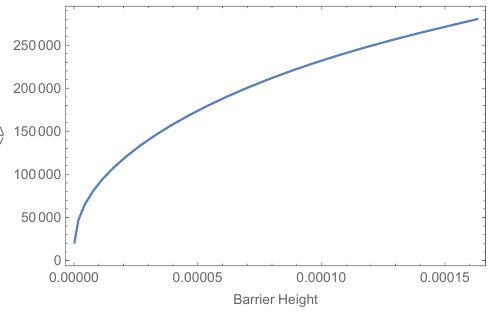
Figure 12 . The correlation between the mean kinetic time h t i and the barrier height for the phase transition process from the two black hole phase to the unstable wormhole